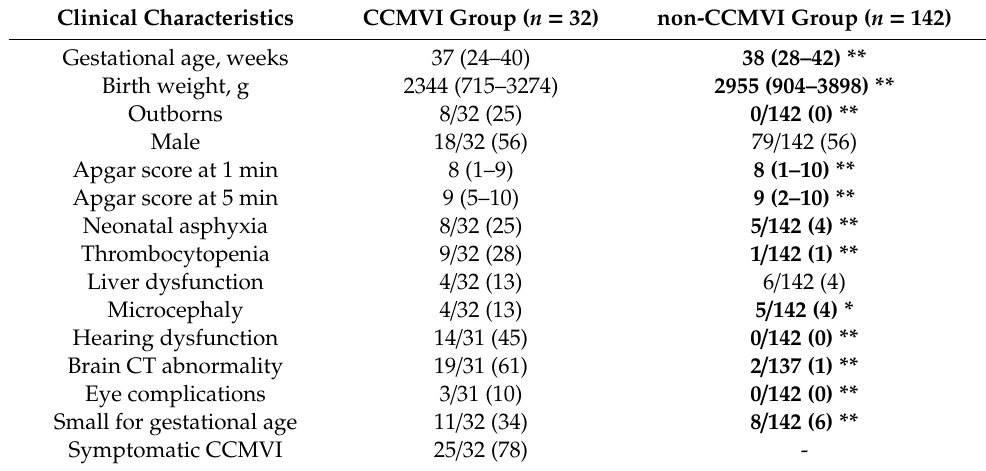
Table 1. Clinical characteristics of infants with and without CCMVI diagnoses confirmed by